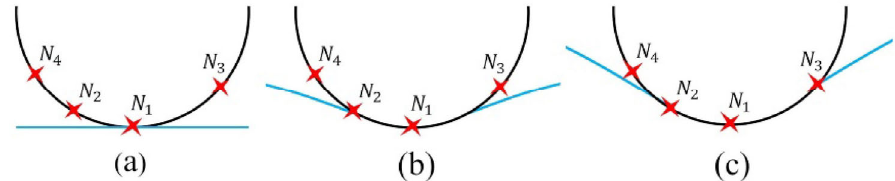
Fig. 2 The contact process of a rigid rough surface on an elastic half-space. (a) Before the load is applied, (b) two nodes in contact, and (c) three nodes in